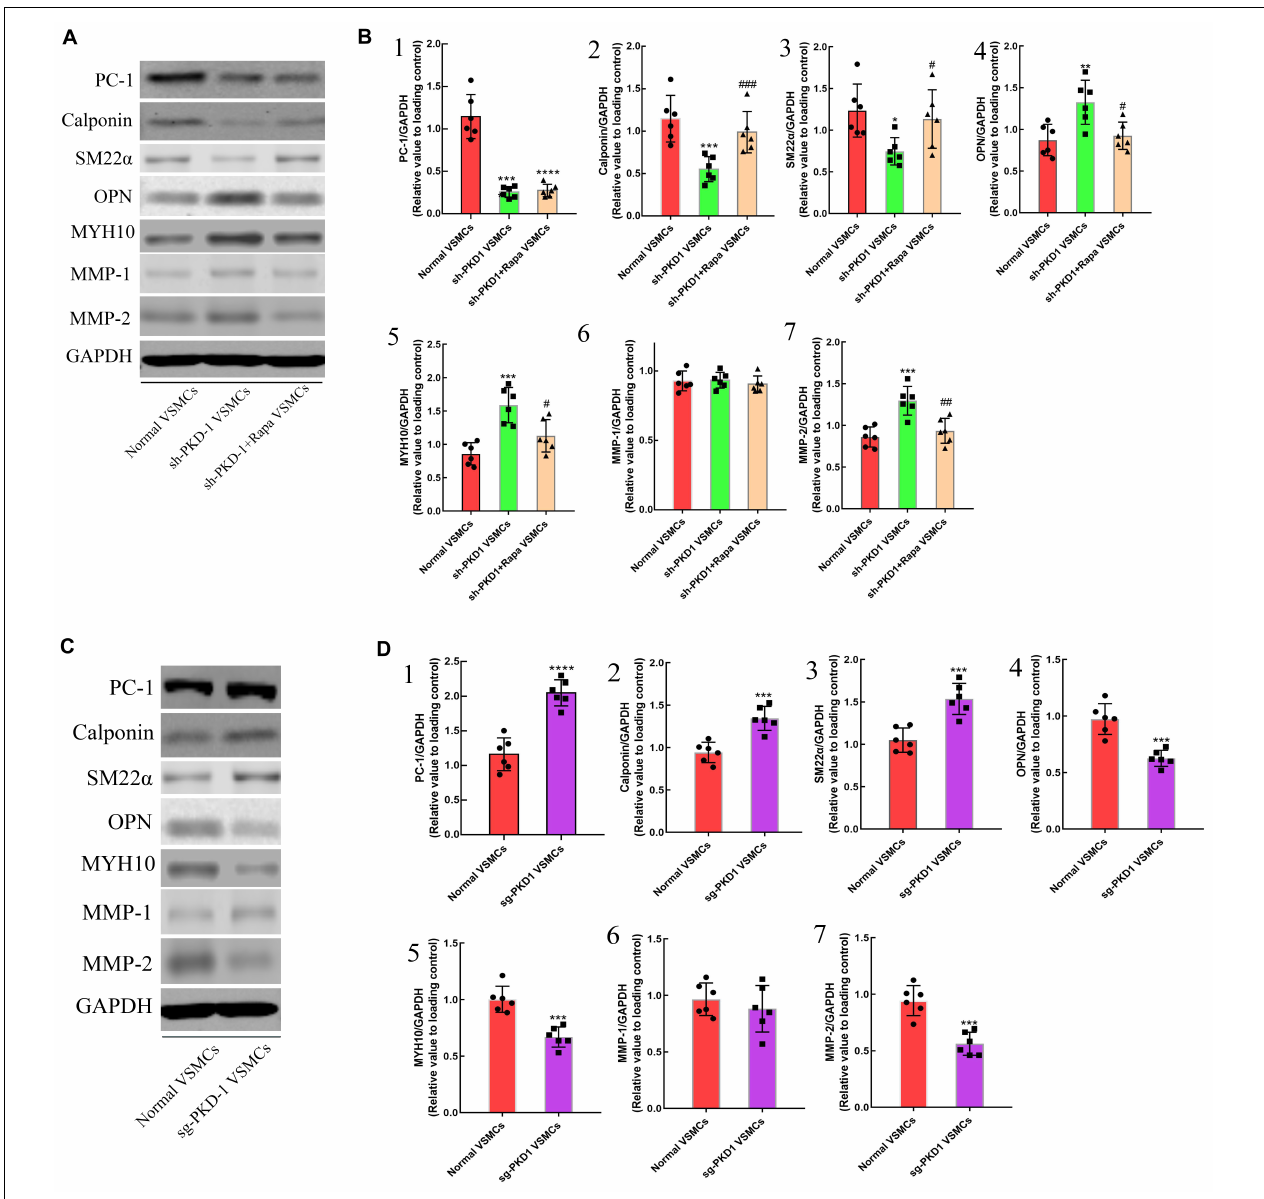
FIGURE 3 | The effects of downregulation and overexpression of PKD-1 on the phenotypes of aortic VSMCs ( n = 6 for each group). (A) PKD-1 knockdown inhibited the expression of (A,B1) PC-1 ( p < 0.0001, p < 0.0001), (A,B2) calponin ( p = 0.0001, p = 0.0008) and (A,B3) SM22 α ( p = 0.0053, p = 0.0194) as well as elevated the expression of (A,B4) OPN ( p < 0.0001, p = 0.0037), (A,B5) MYH10 ( p < 0.0001, p = 0.0001), (A,B7) MMP-2 ( p < 0.0001, p = 0.0003) Rapamycin didn’t affect the expression of (A,B1) PC-1 ( p < 0.0001, p < 0.0001) in sh-PKD-1 VSMCs but elevated the expression of (A,B2) calciponin ( p = 0.0026, p = 0.0038) and (A,B3) SM22 α ( p = 0.0352, p = 0.034) and downregulated the expression of (A,B4) OPN ( p = 0.0009, p = 0.0101), (A,B5) MYH10 ( p = 0.0002, p = 0.0105), (A,B7) MMP2 ( p < 0.0001, p = 0.0031). (A,B6) Showed the protein expression of MMP-1 among three groups. Treatment of sg-PKD-1 enhanced the expression of (C,D1) PC-1 ( p < 0.0001, p < 0.0001), (C,D2) calciponin ( p = 0.0054, p = 0.0004) and (C,D3) SM22 α ( p = 0.0005, p = 0.0003), but inhibited the expression of (C,D4) OPN ( p = 0.0125, p = 0.0002), (C,D5) MYH10 ( p = 0.0078, p = 0.0002), (C,D7) MMP2 ( p < 0.0001, p = 0.0009). (C,D6) Showed the protein expression of MMP-1between normal and sg-PKD-1 VSMCs. * p < 0.05, ** p < 0.01, *** p < 0.001, **** p < 0.0001 (compared with normal VSMCs); ## p < 0.01, ### p < 0.001 (compared with TAD VSMCs). # Means the comparison between sh-PKD1 and sh-PKD1 + Rapa VSMCs. p < 0.05.